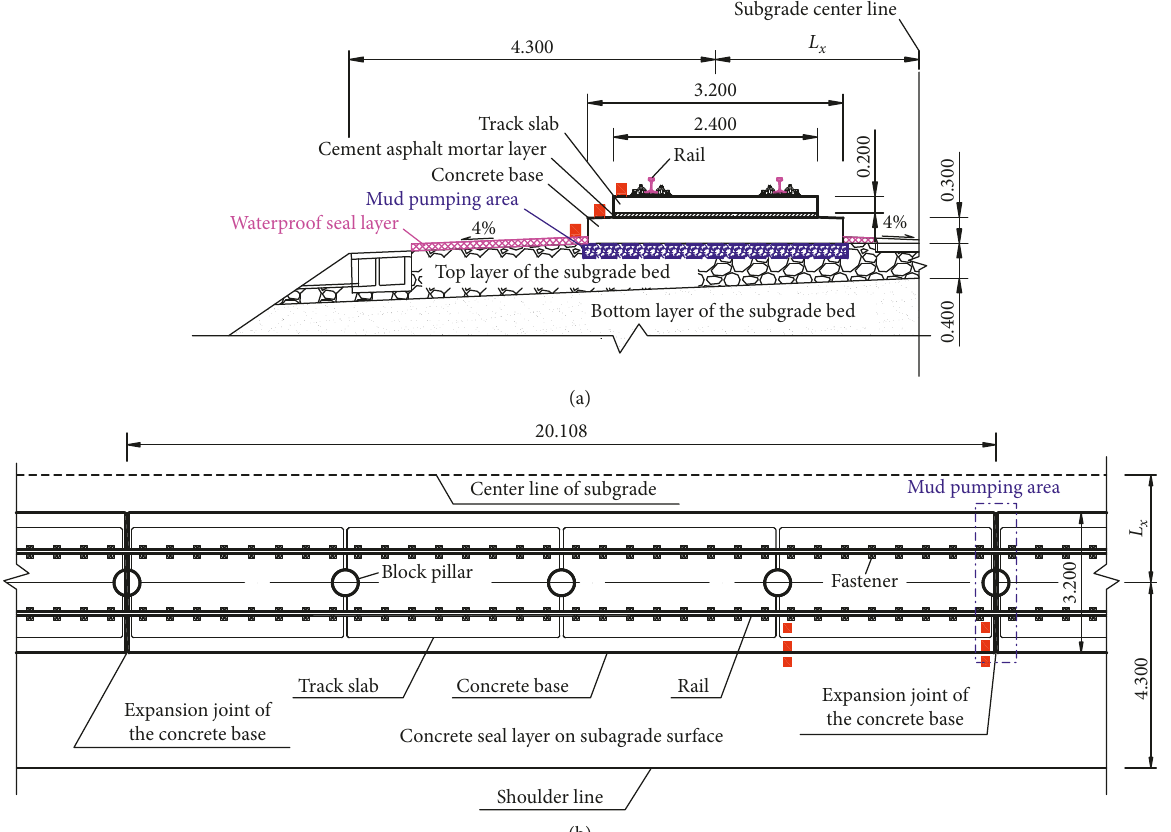
Figure 2: The structural characteristics of the ballastless track-subgrade and the layout of the test position (units in meter); , test position. (a) The cross-sectional profile of the ballastless track-subgrade. (b) The plane section of the ballastless track-subgrade.